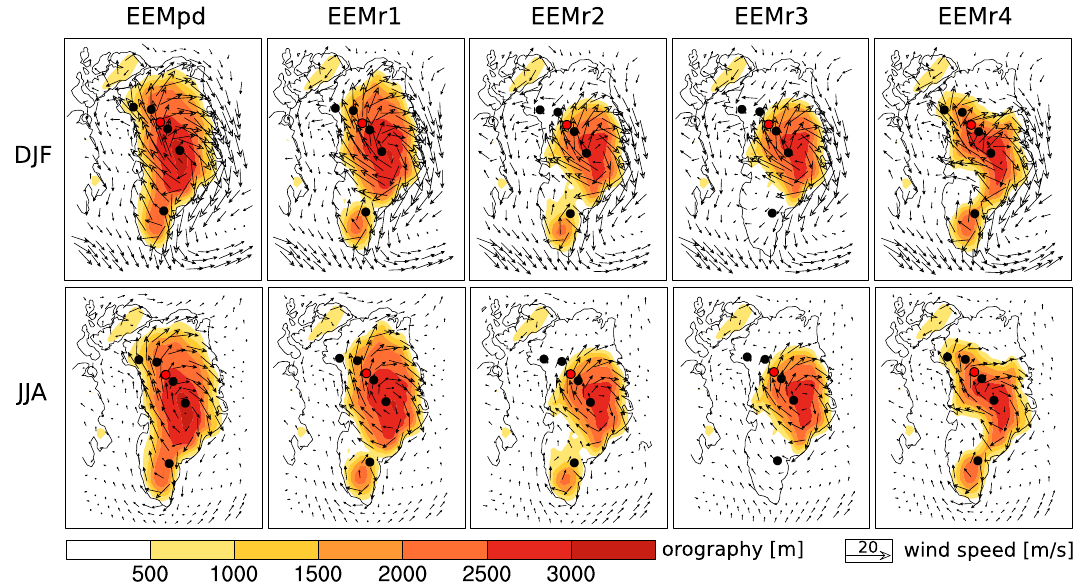
Figure 7. DJF and JJA Greenland surface winds (taken at the lowest terrain-following model level) in the Eemian simulations. The vector length scales with the wind velocity (ms − 1 ). The shading denotes the local surface elevation (500m contour